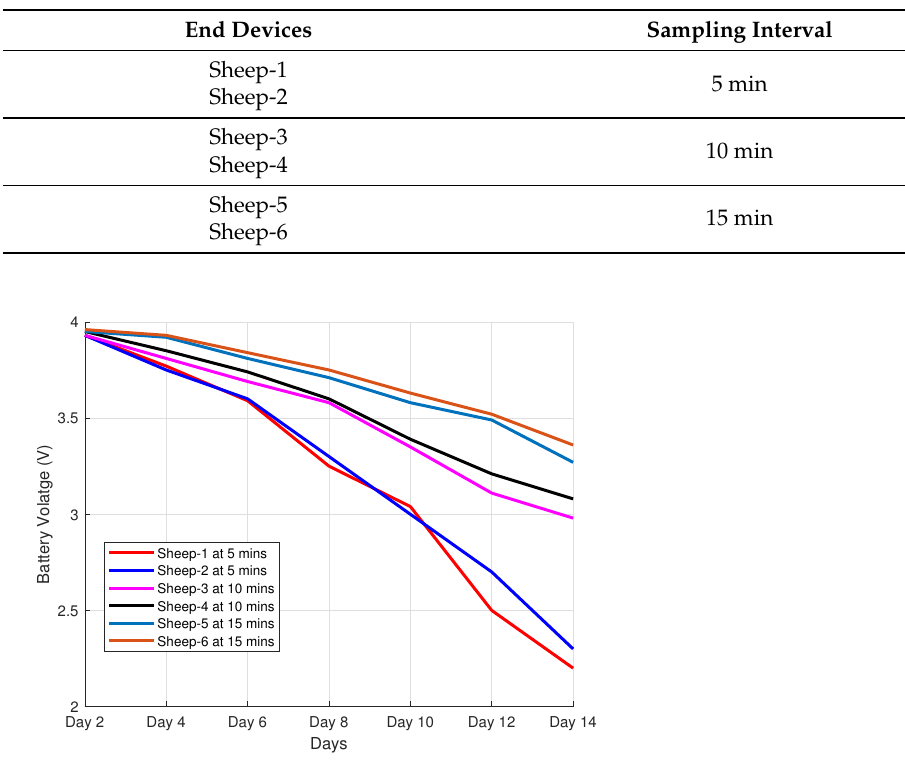
Figure 11. Battery discharge